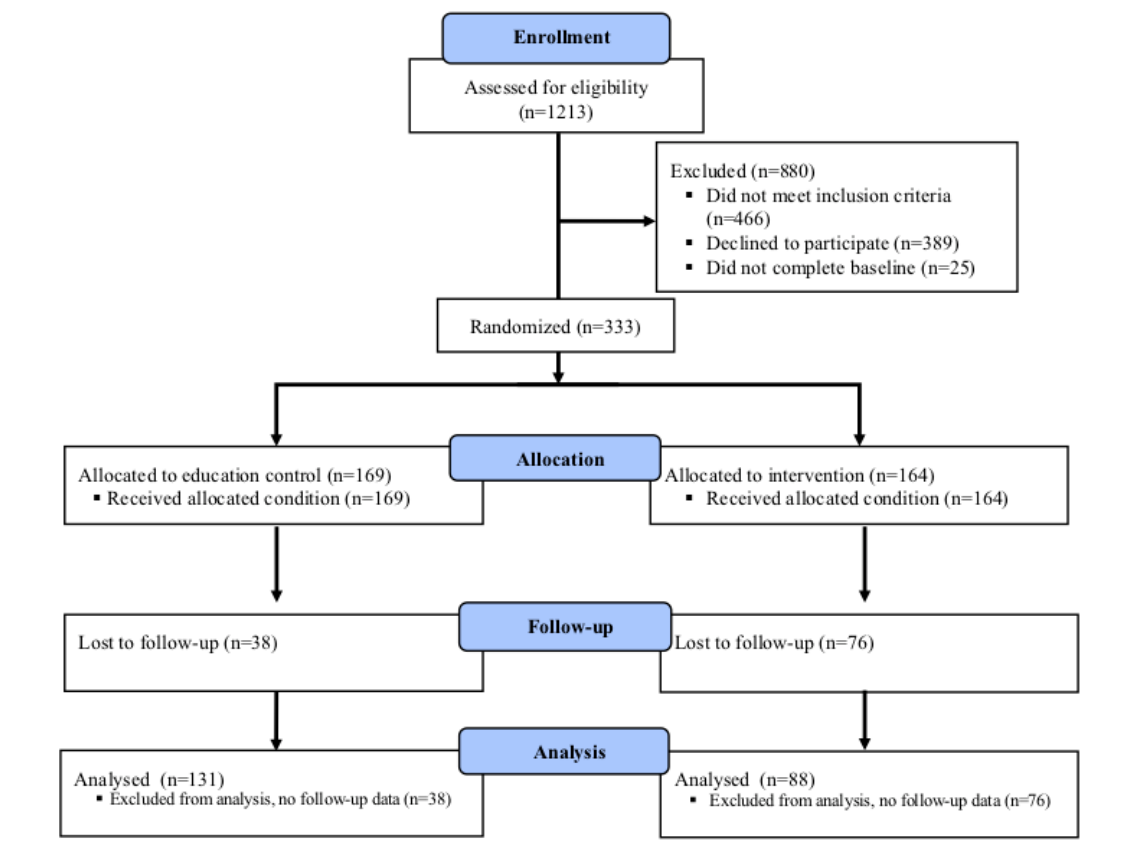
Figure 3. Consolidated Standards of Reporting Trials flow